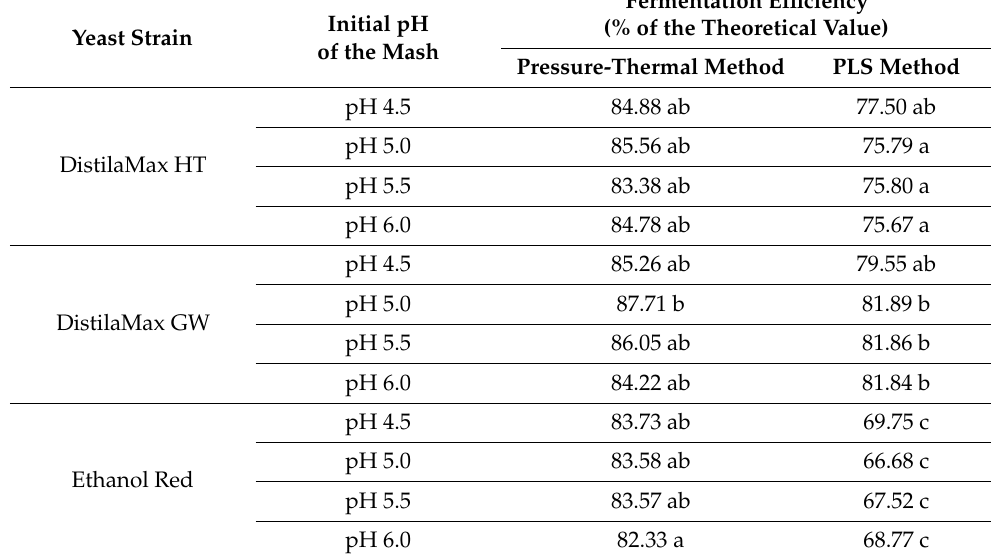
Table 4. Fermentation efficiency of rye mashes.